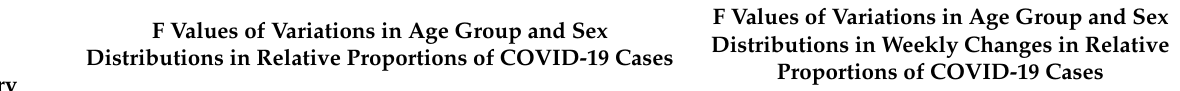
Table 1. Summary F values for variations among age groups and between the two sexes in relative proportions of COVID-19 cases and in weekly changes between successive weeks in the relative proportions of COVID-19 cases in 13 countries.